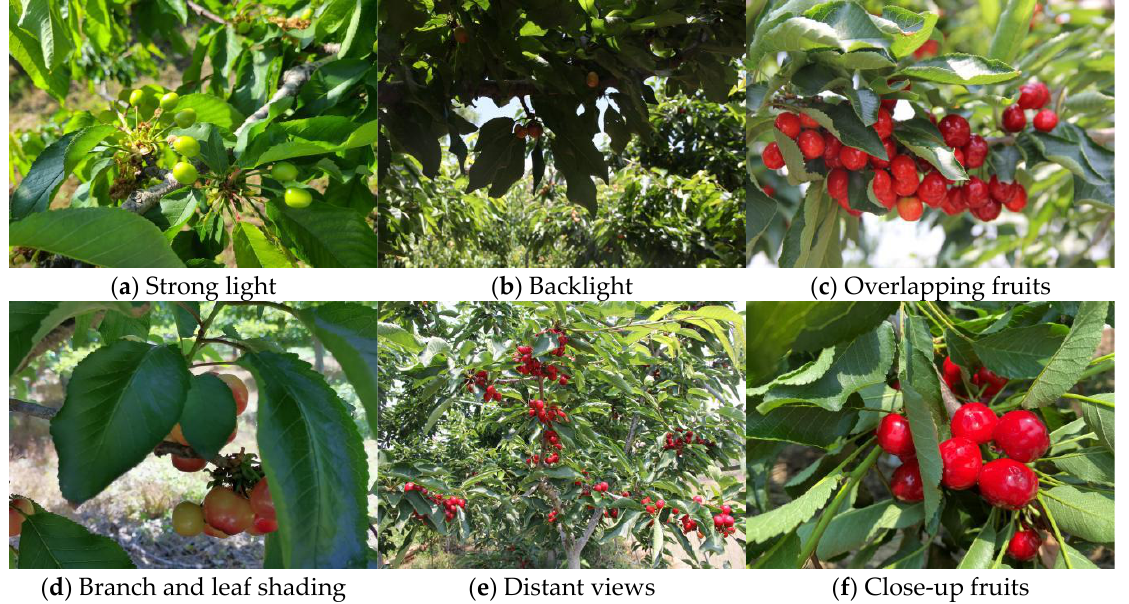
Figure 2. Part of the SweetCherry dataset. ( a ) Strong light. ( b ) Backlight. ( c ) Overlapping fruits. ( d ) Branch and leaf shading. ( e ) Distant views. ( f ) Close-up fruits.